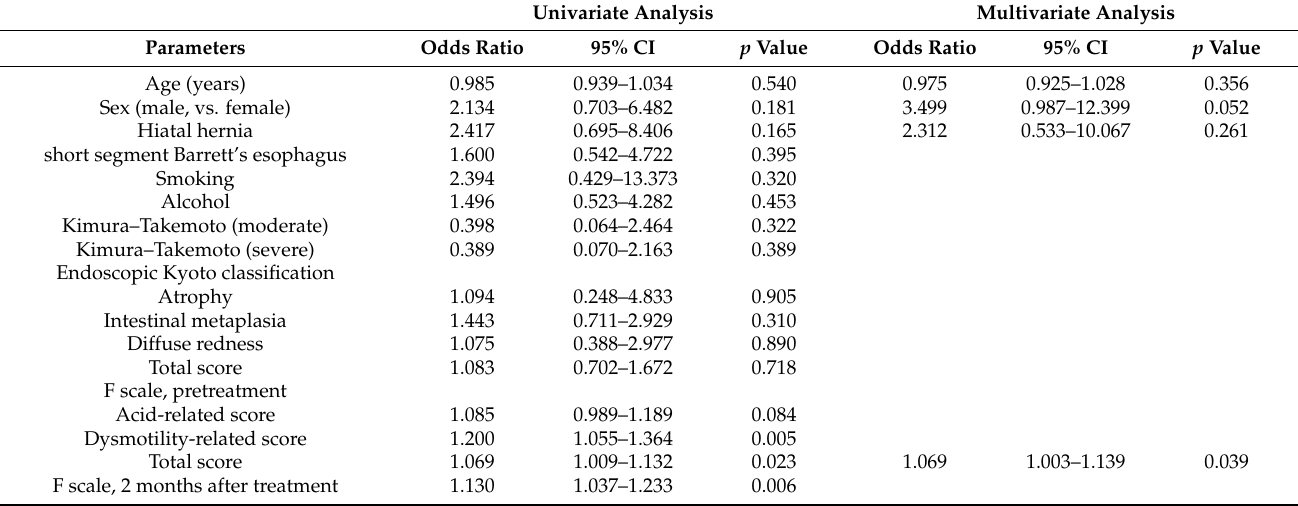
Table 5. Univariate and multivariate analysis for the development of reflux esophagitis. Univariate Analysis Multivariate